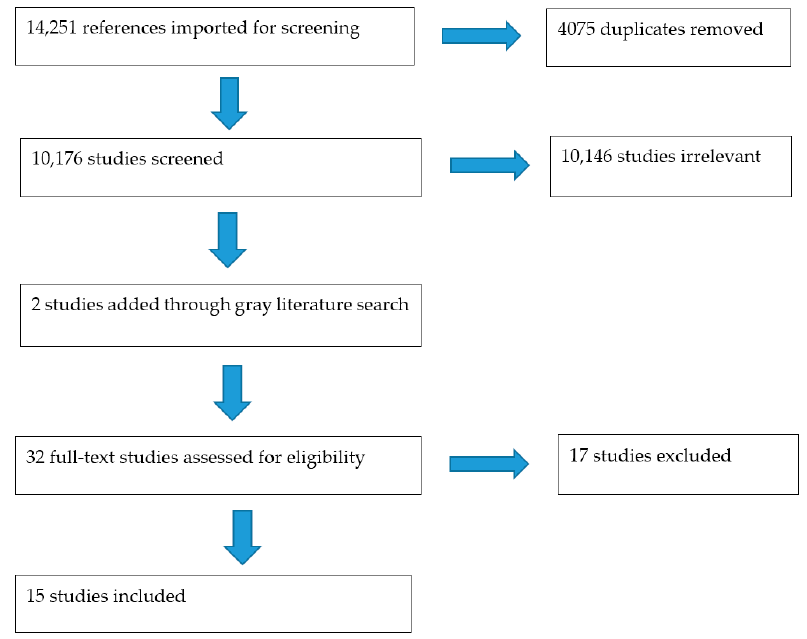
Figure 1. Preferred reporting items for systematic reviews and meta-analysis flow chart.